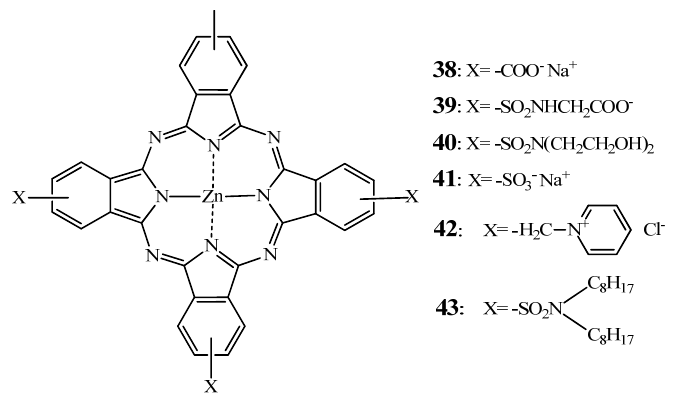
Figure 15. Chemical structure of phthalocyanines 38–43